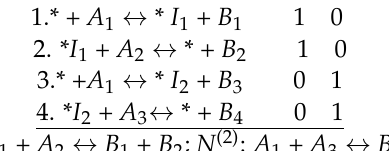
Figure 2. The ratio of reaction products in the Prins condensation of isopulegol with acetone as a function of the total concentration of acid sites. Points—experimental data from [19], calculations— Equation (55). The calculated values of ln ( k + 3 C A 0.50338 ± 0.46502 and 0.13566 ±